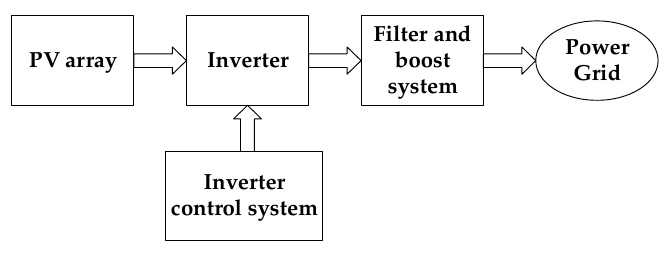
Figure 1. Block diagram of PV power generation systems.